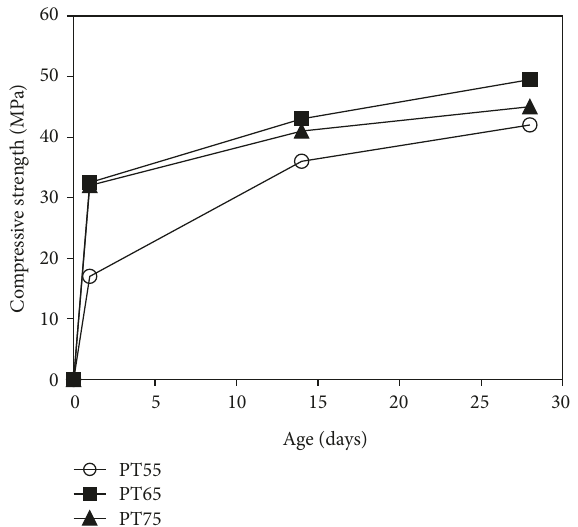
Figure 6: Compressive strength versus peak temperature.